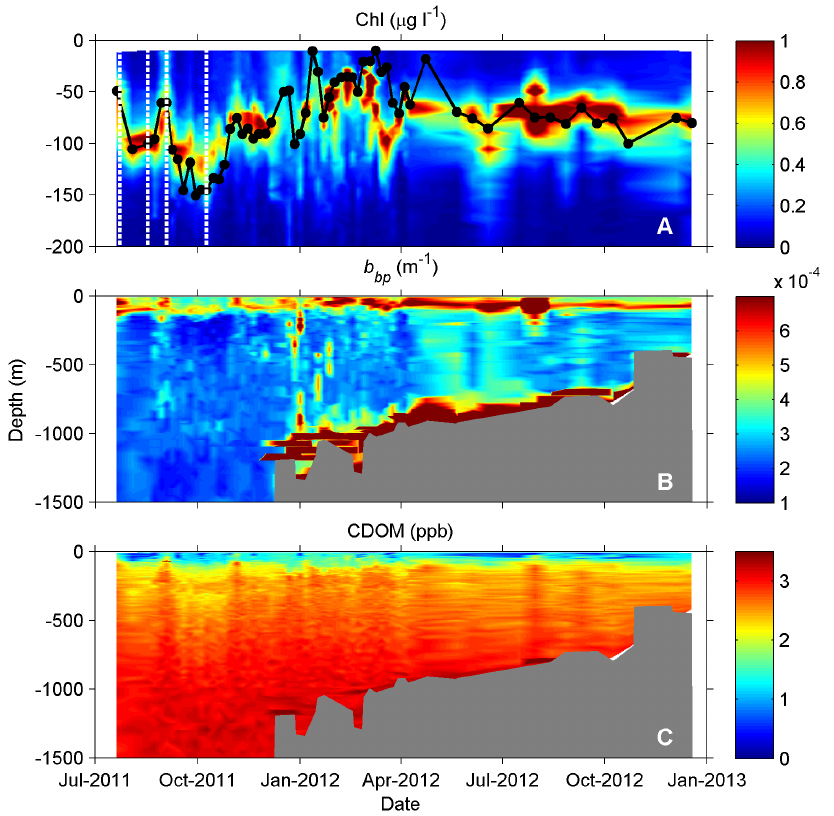
Figure 3. Contour plots demonstrating spatiotemporal variability in bio-optical float profiles. (A) Chl, (B) b bp , and (C) CDOM. Note difference in vertical axes for Chl (upper 200 m) versus b bp and CDOM (entire depth profile) to emphasize depth zones of maximum variability. For reference, the density layer r =1023.6 is shown in panel A (black line) with sample times (black dots), and bottom depth is shown in panels B and C (shaded grey). The times corresponding to SSHA imagery in Fig. 2 are indicated in panel A (white dashed lines) to show float location relative to the